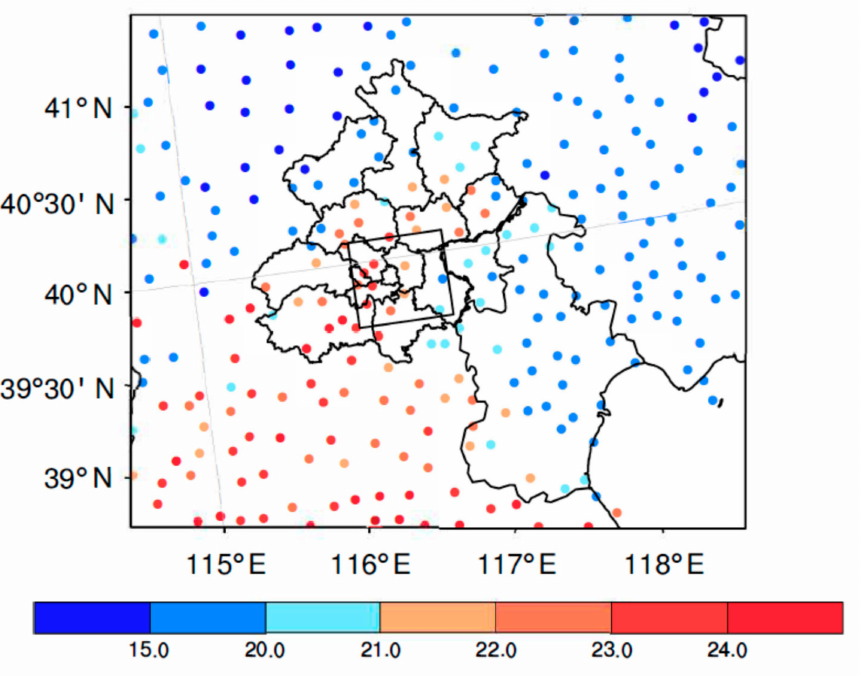
Figure 7. Spatial distribution of 2 m air temperature at 0700UTC on 21 May 2020. The black rectan- gular box indicates the study area where temperatures prior to the start of rainfall are statistically analyzed (116.12 ◦ –116.79 ◦ E, 39.65 ◦ –40.115 ◦